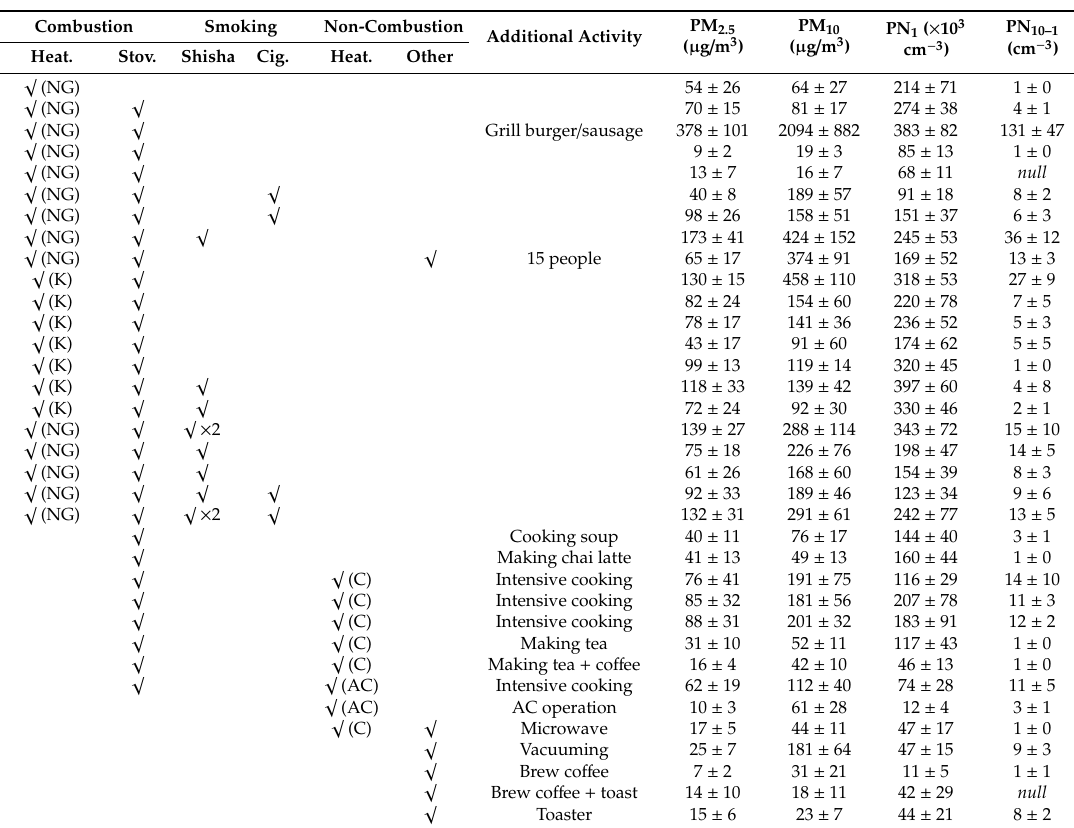
Table 7. Classification of indoor activities and corresponding particle number and mass